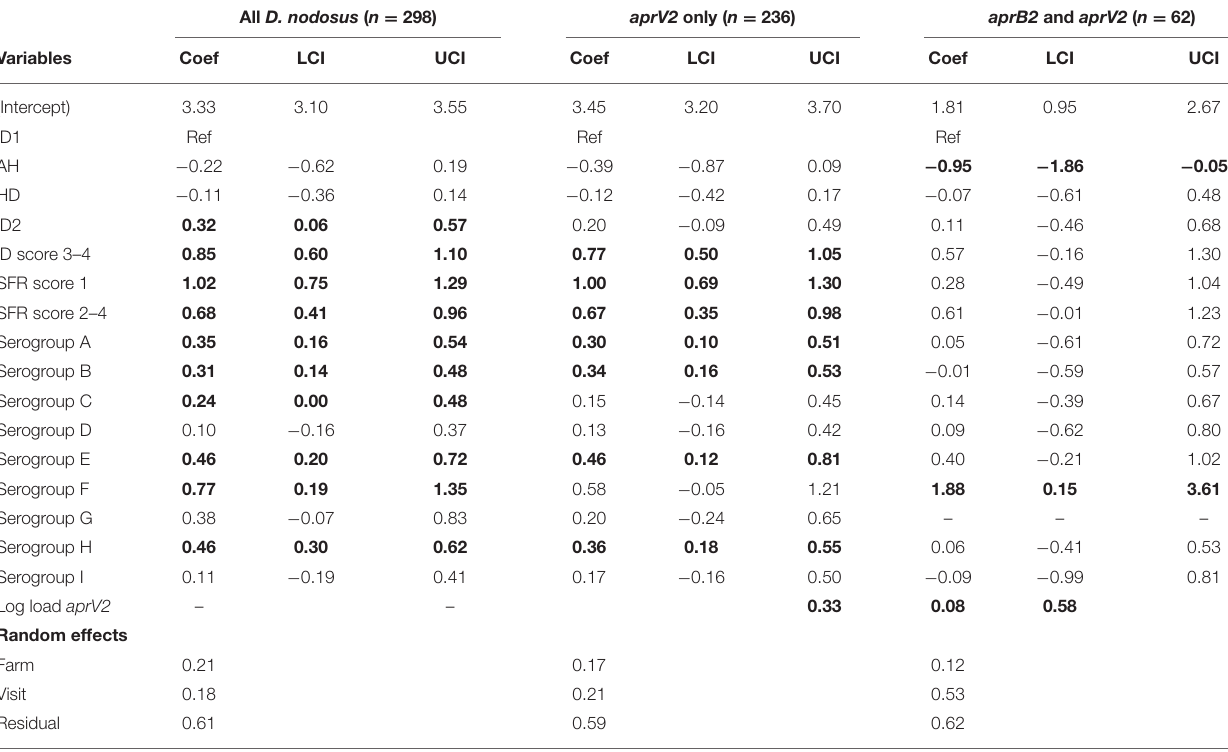
TABLE 5 | Three multivariable mixed effects regression models of pooled samples by load of all D. nodosus , only aprV2, and aprB2 adjusted for aprV2 from 3 visits to 24 sheep flocks in England with clinical footrot. All D. nodosus ( n = 298) aprV2 only ( n = 236) aprB2 and aprV2 ( n =